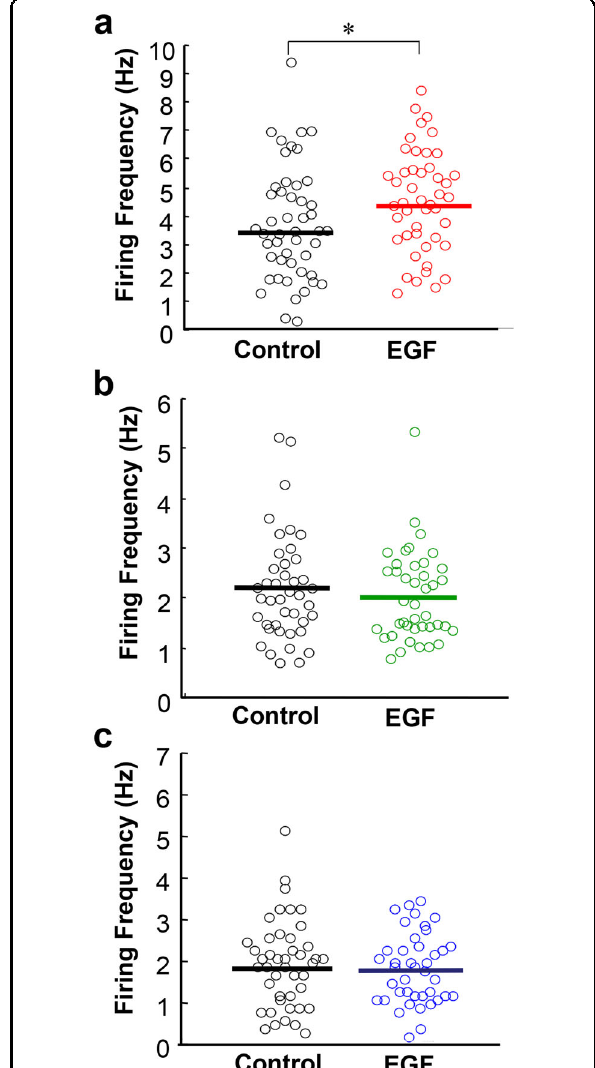
Fig. 1 Differences in spontaneous neural activities of putative monoaminergic neurons in epidermal growth factor model rats. In vivo extracellular single ‐ unit recordings in the ventral tegmental area (VTA), locus coeruleus (LC), and dorsal raphe nucleus (DRN) of anesthetized rats. a The distributions of fi ring rates of putative VTA dopaminergic neurons are compared between the EGF model and control rats ( n = 48 cells from 5 control rats, n = 46 cells from 5 EGF model rats,). b The distributions of fi ring rates of putative LC noradrenergic neurons are similar ( n = 42 cells from 7 control rats, n = 41 cells from 7 EGF model rats,). c The distribution of fi ring rates of putative DRN serotonergic neurons are comparable n = 44 cells from 5 control rats, n = 41 cells from 5 EGF model rats). * P < 0.05, Mann – Whitney U